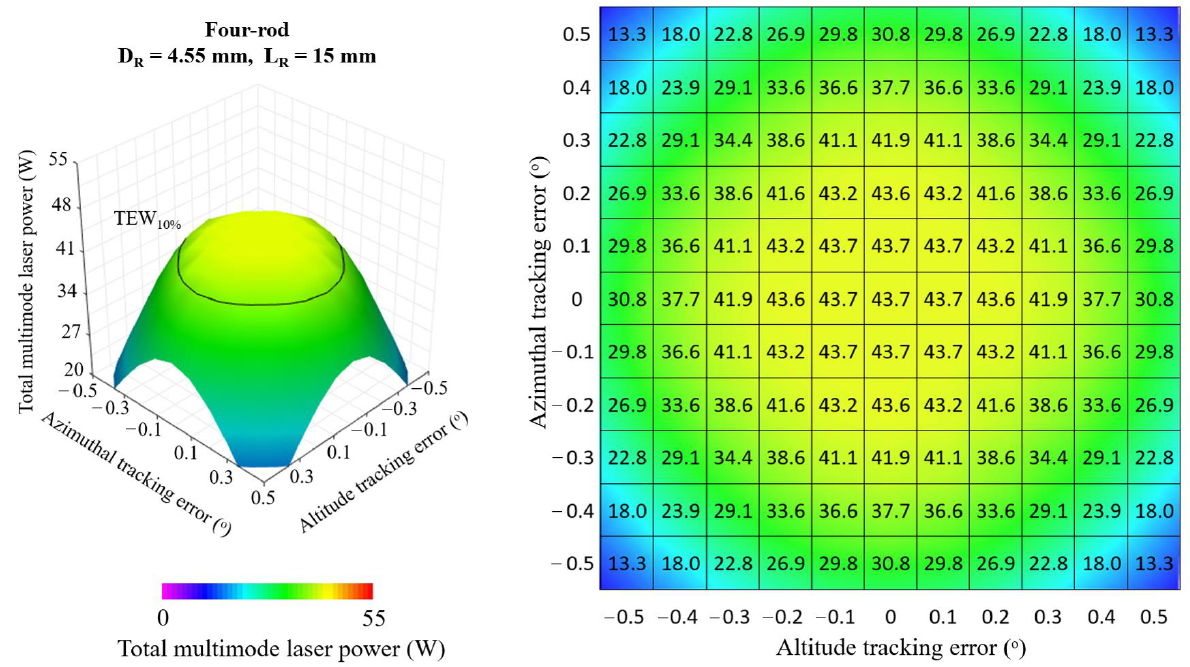
Figure 10. Total multimode solar laser power as a function of the simultaneous tracking error in altitude and azimuthal directions, ranging from the optimal alignment (0.0 ◦ ) to 0.5 ◦ , for the four-rod scheme with D R = 4.55 mm and L R = 15 mm.